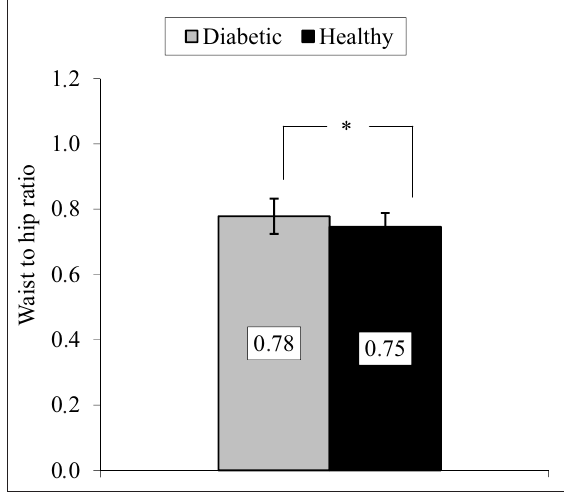
Figure 3. Waist to hip ratio in diabetic and healthy women Note. * – p <